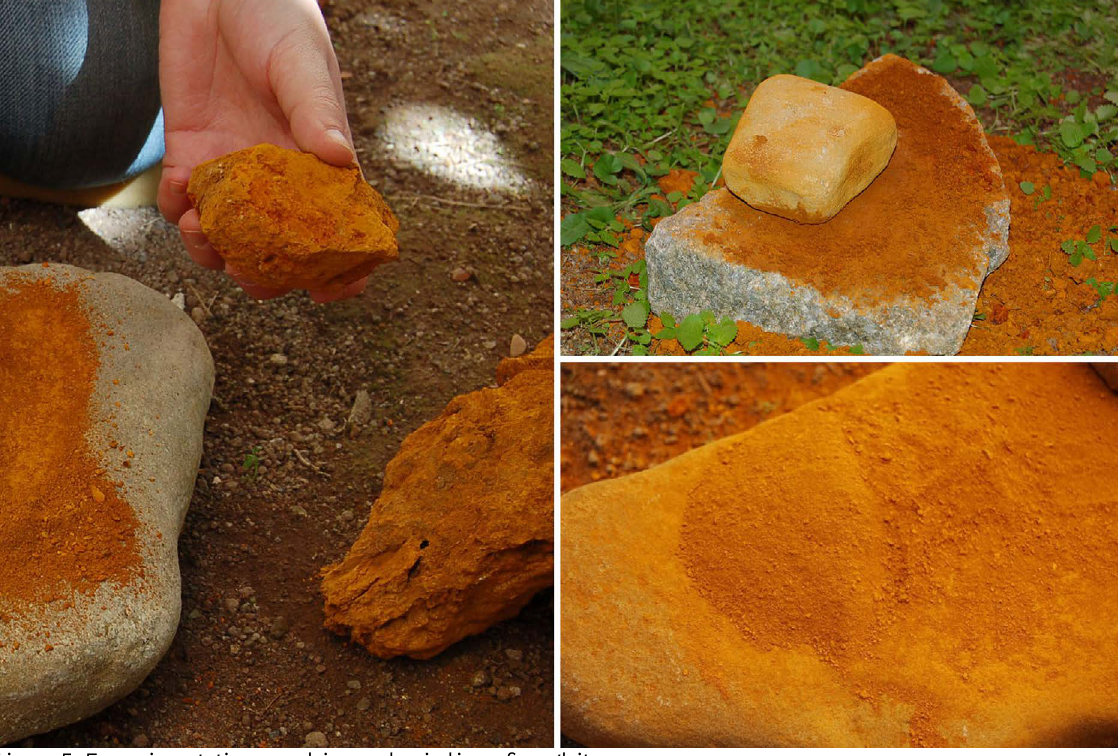
Figure 5. Experimentation: crushing and grinding of goethite